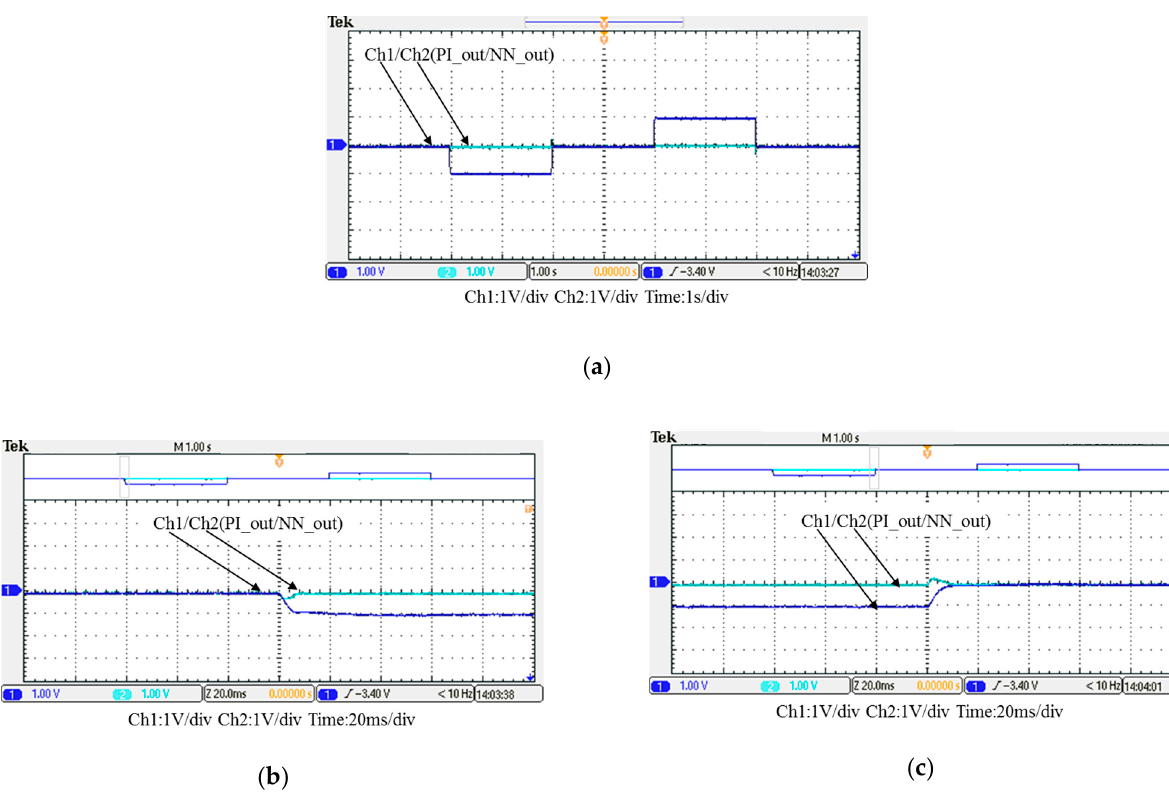
Figure 34. Case 2 implementation result: reactive power controller outputs: ( a) full view; ( b ) detailed view near t 1 ; ( c ) detailed view near t 2 (all control signals are in V).